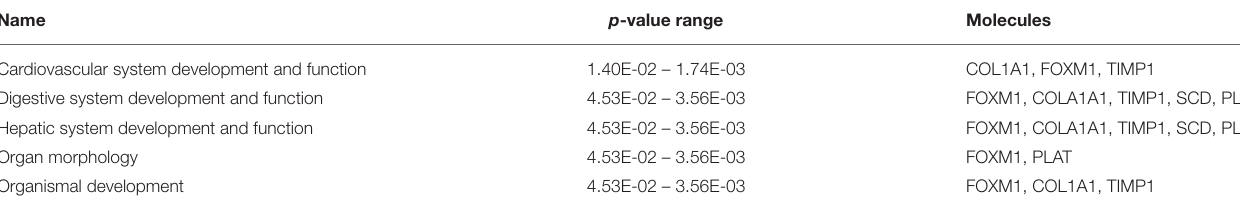
TABLE 8 | Physiological system development and function between Phb1 + / − and WT.